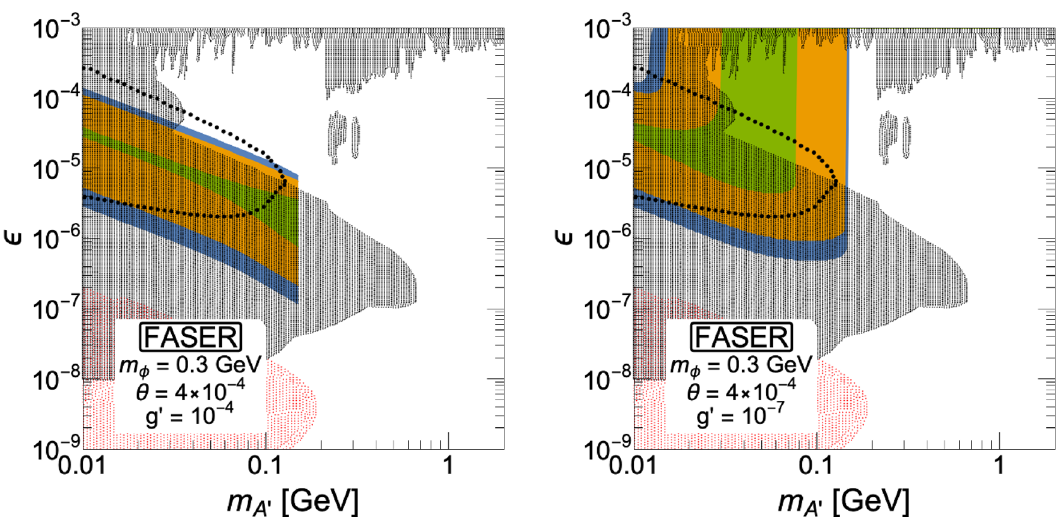
Figure 4 . The same plots as figure 2 for FASER. The parameters are taken as g 0 = 10 − 4 (left) and 10 − 7 (right) while other parameters are fixed as m φ = 0 . 3 GeV and θ = 4 × 10 − 4